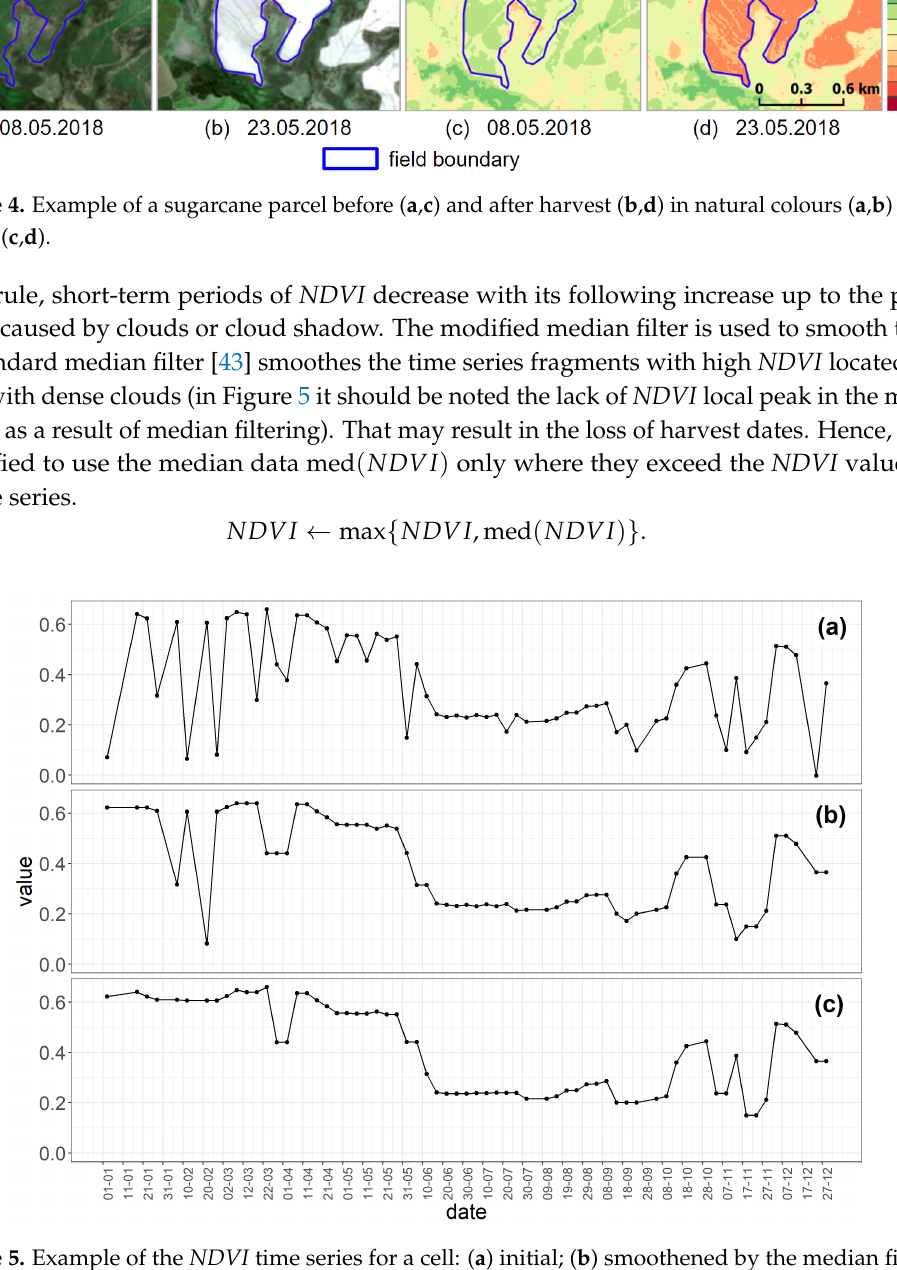
Figure 5. Example of the NDVI time series for a cell: ( a ) initial; ( b ) smoothened by the median filter; ( c ) smoothened by the modified median